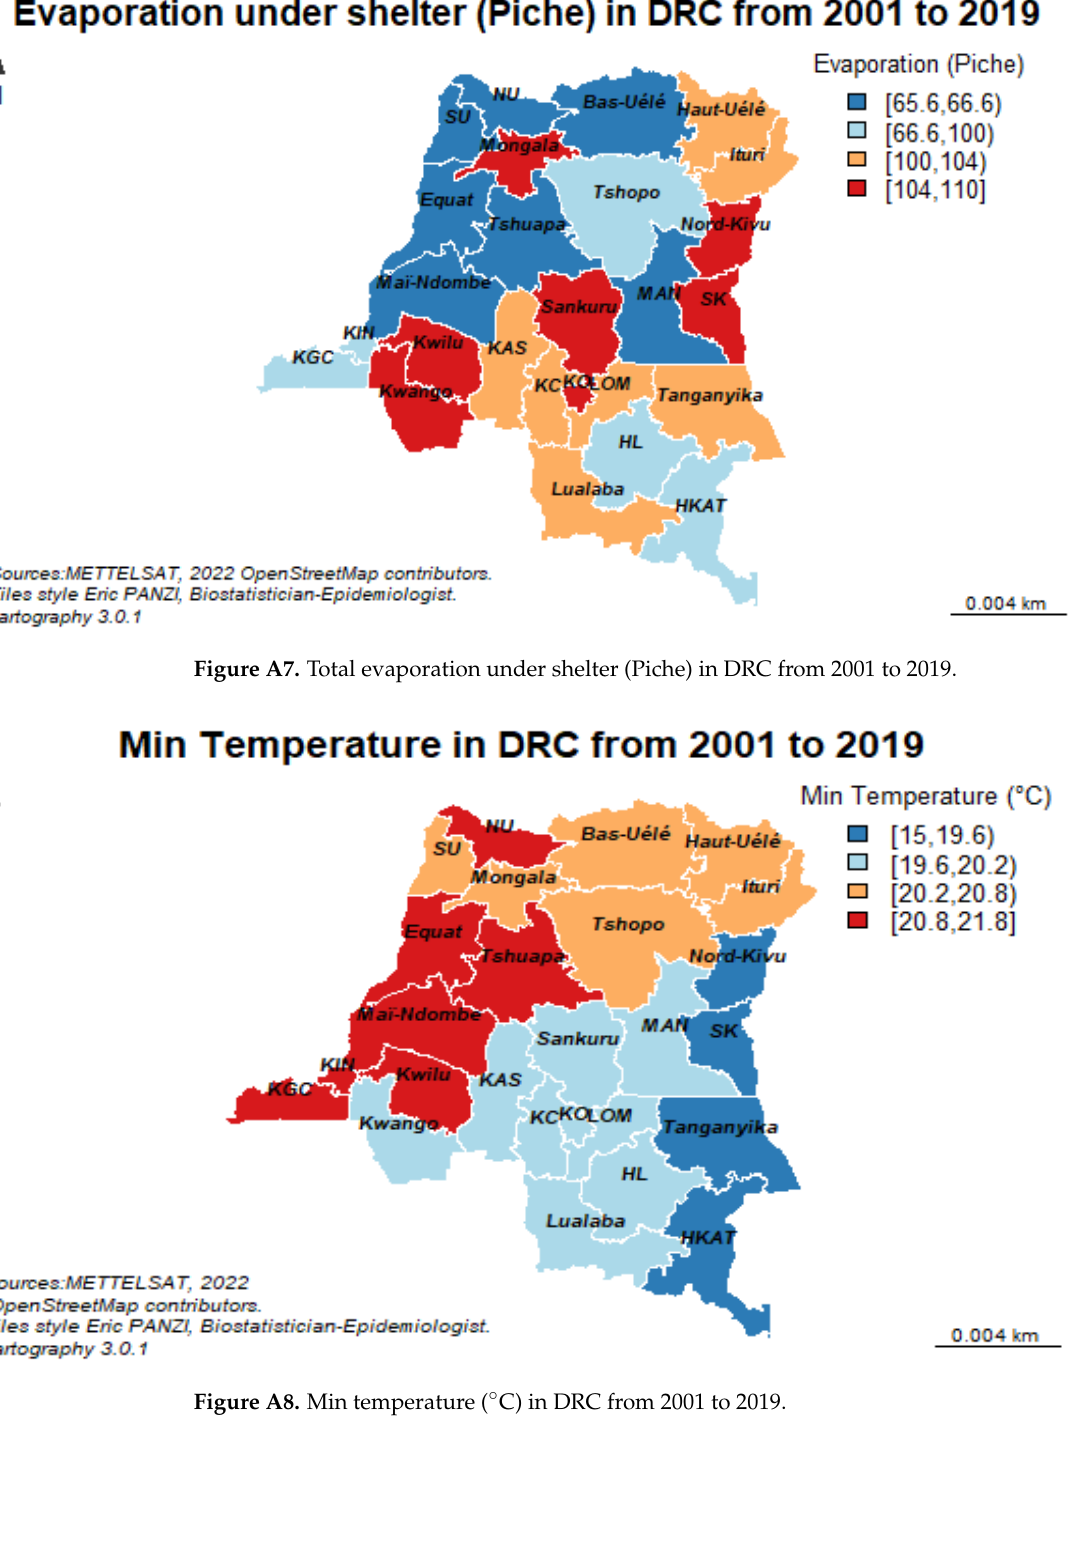
Figure A6. Evaporation (Piche) in DRC from 2001 to 2019.